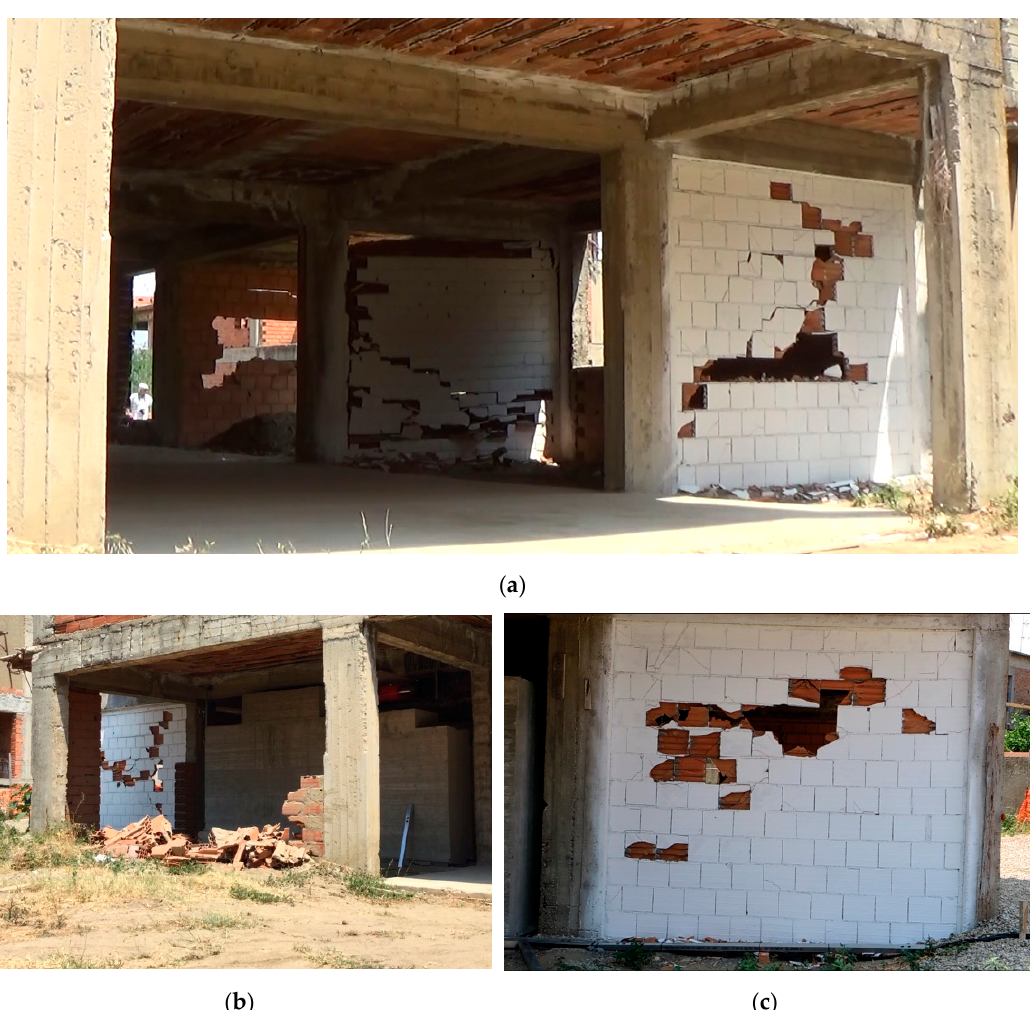
Figure 14. Infill damage at run #6, 21.6 mm—0.58%: From left to right, infills i9, i10, i11 ( a ); infill i3 ( b ); infill i2 ( c ). Buildings 2020 , 10 , x FOR PEER REVIEW